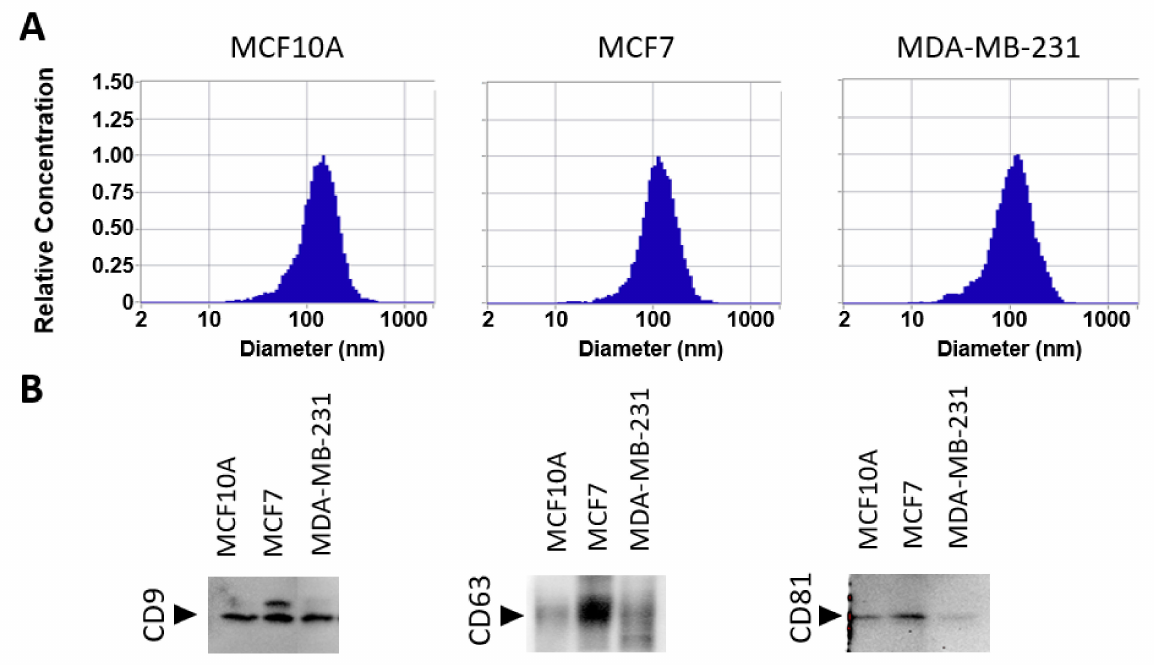
Figure 1. Characterization of extracellular vesicles by nanoparticle tracking analysis (NTA) and Western blot. ( A ) NTA characterization showing size distributions of isolated sEVs from MCF10A, MCF7, and MDA-MB-231 cell lines. ( B ) Western blot analysis of sEV marker proteins, CD9, CD63, and